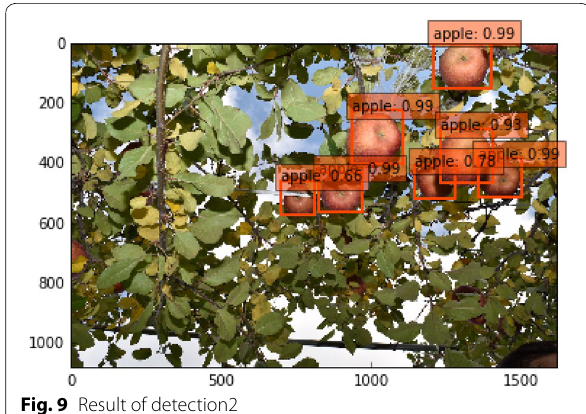
Fig. 9 Result of detection2